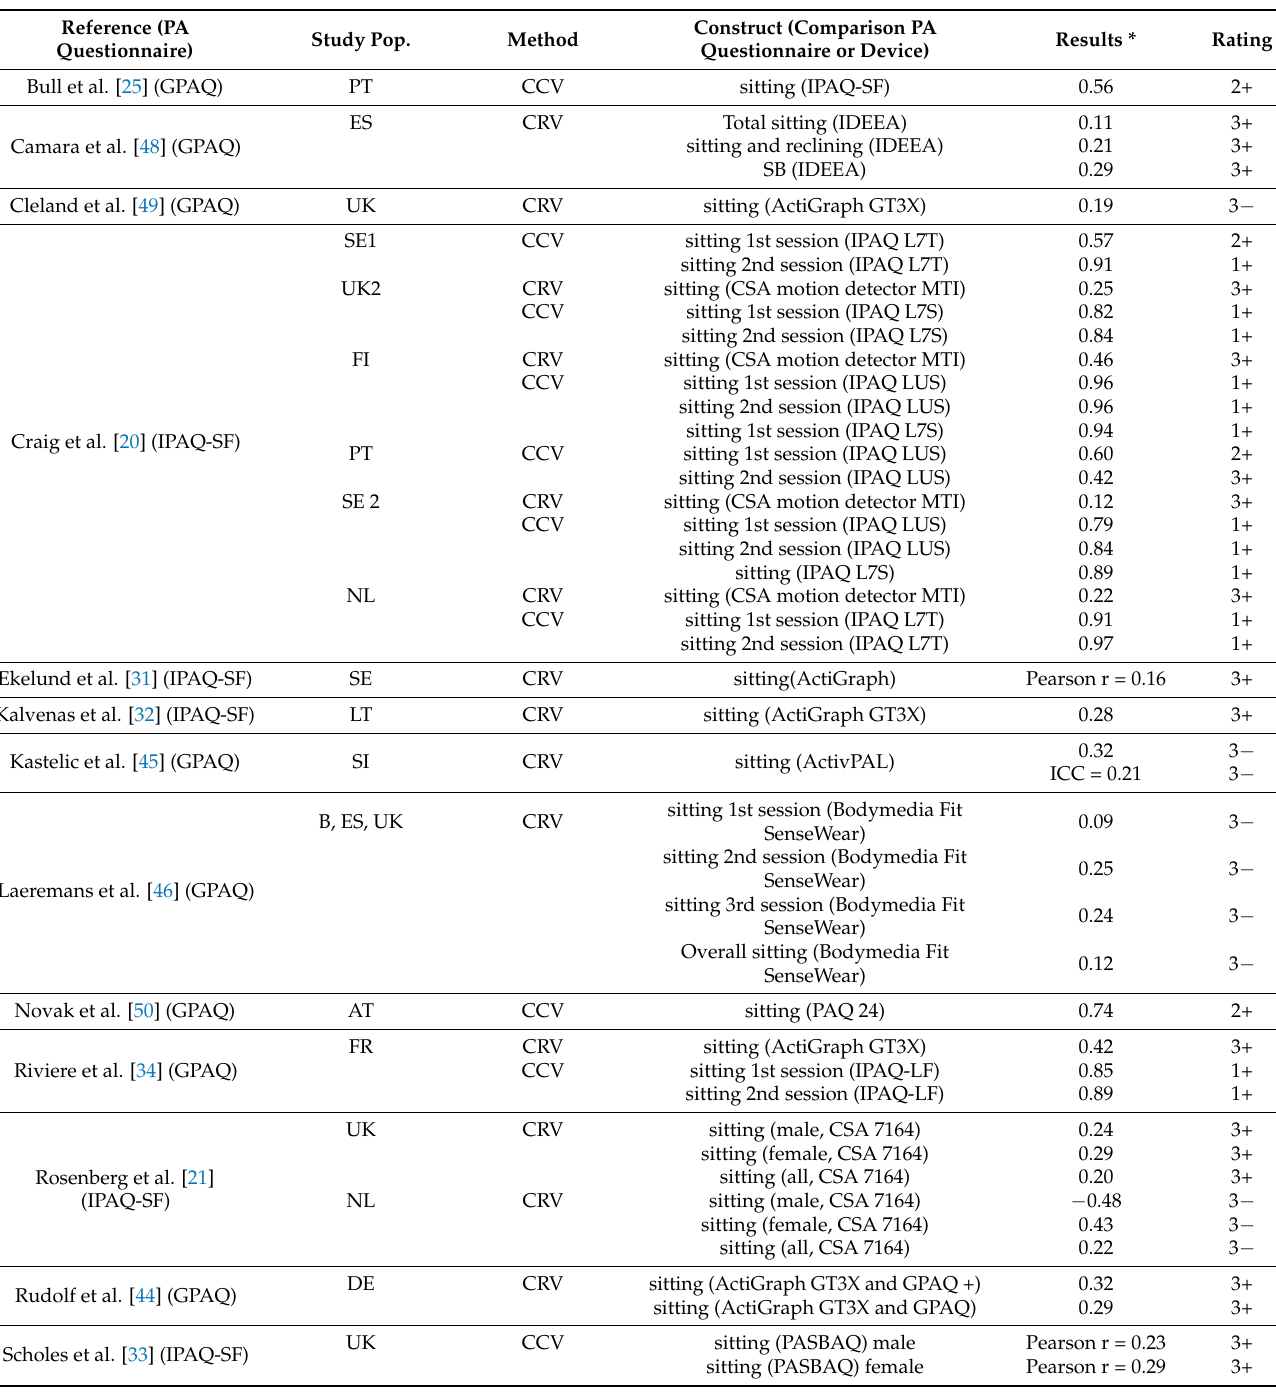
Table 4. Results for concurrent and criterion validity for SB in selected